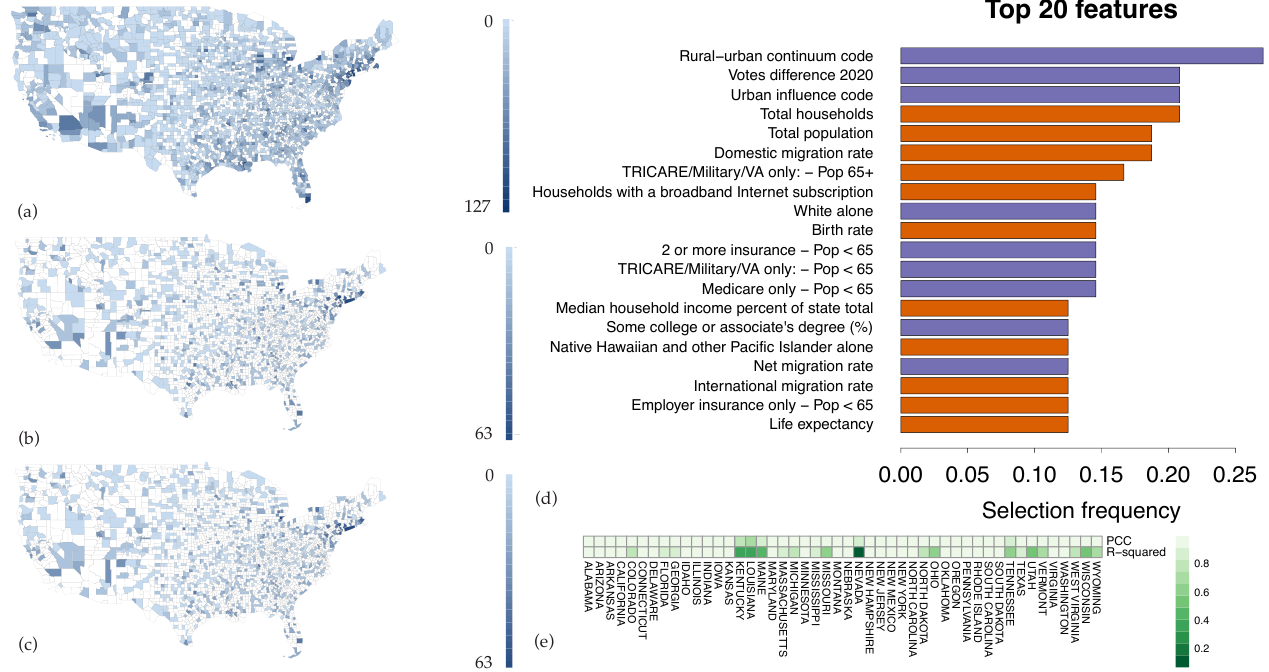
Figure 1. Spatial modeling of case dynamics during initial phase of pandemic. Blue shade indicates observed cases over first 30 days in counties used for model training ( a ) and testing (observed) ( b ), with predicted case counts in test counties shown in ( c ). Cases were aggregated over 30 days in each county in the maps. ( d ) The most predictive top 20 features selected overall by the algorithm for the initial phase. Purple-colored features are negatively correlated with case counts, and the orange-colored features are positively correlated with the case counts. ( e ) PCC and R 2 values of all